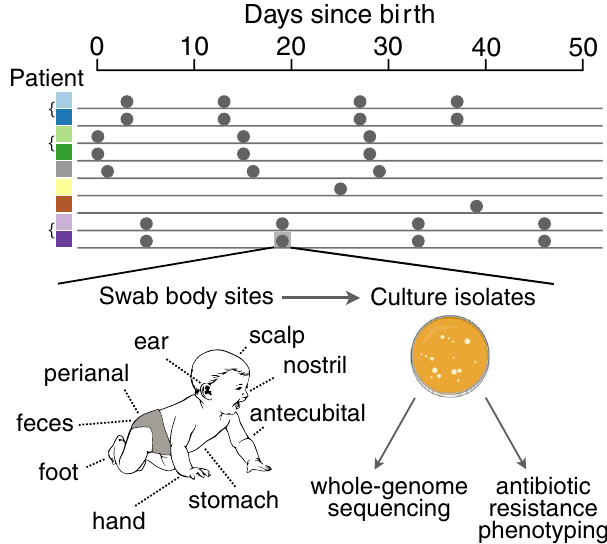
Fig. 1 Spatiotemporal sampling of Staphylococcus epidermidis from nine newborn infants. Patients are indicated by color, where different shades of the same color correspond to twins. At each of 1 – 4 time points, infants were swabbed at numerous body sites (not all depicted; see “ Methods ” section). Swabs were cultured on Staphylococcus -selective media (see “ Methods ” section), from which we collected multiple single colonies. Colonies were harvested and subjected to whole-genome sequencing and antibiotic resistance